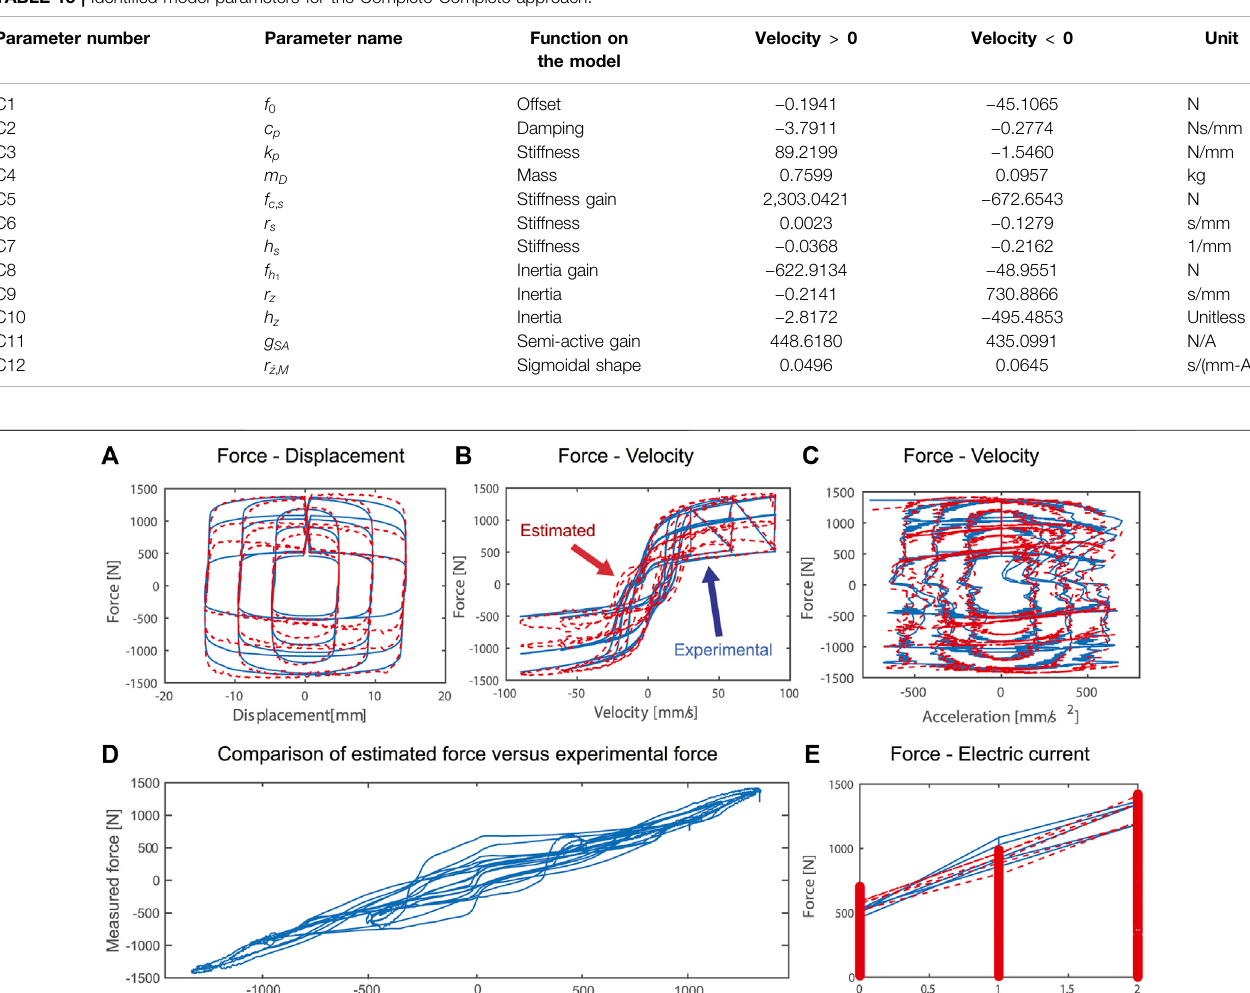
Frontiers in Materials |